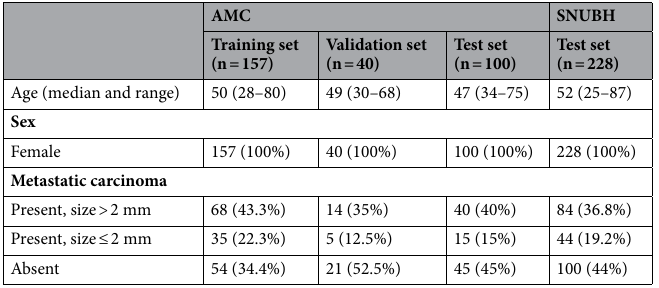
Table 1. Clinicopathologic characteristics of the patients in AMC and SNUBH datasets. AMC, Asan Medical Center; SNUBH, Seoul National University Bundang